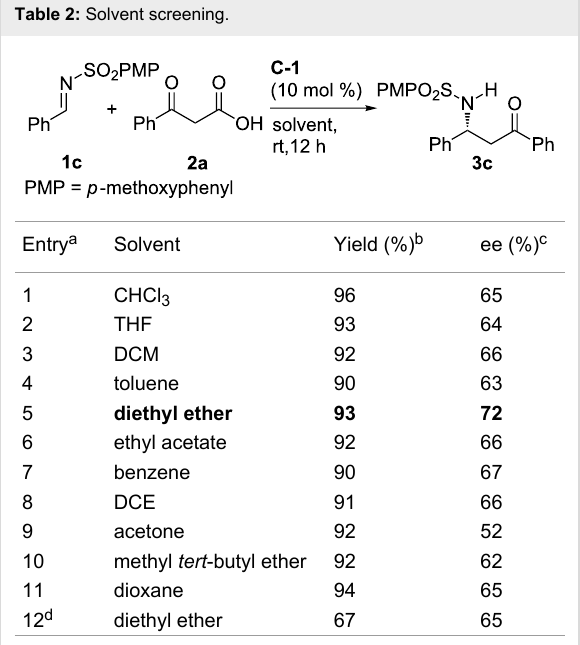
Table 2: Solvent screening.